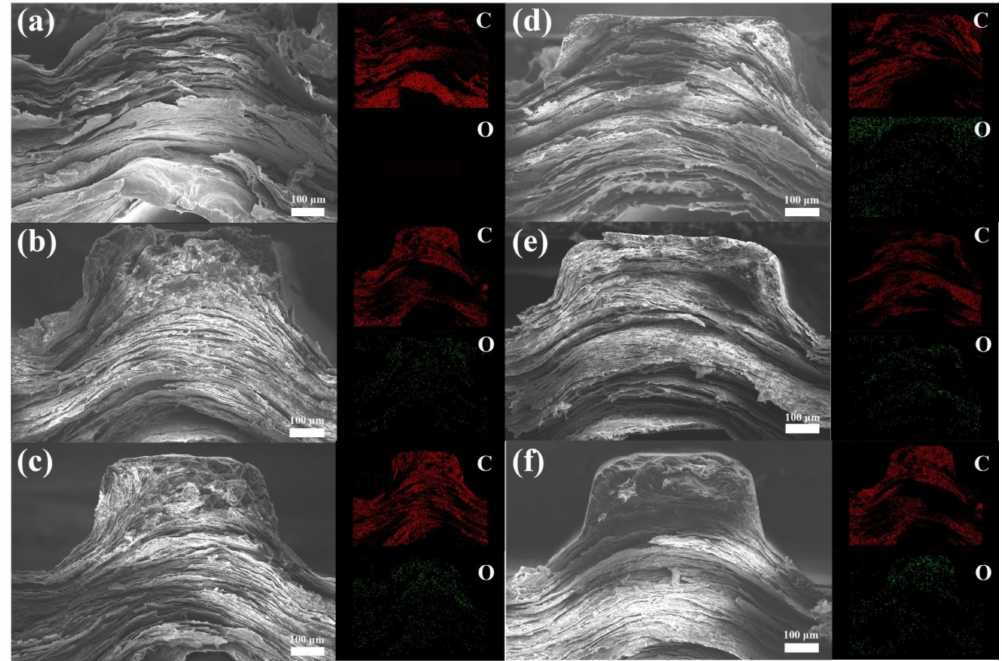
Figure 2. SEM morphology and corresponding EDS map of graphite-resin composite bipolar plates (BPs). ( a ) HU-BP, ( b ) HL-BP, ( c ) HM-BP, ( d ) HH-BP, ( e ) MH-BP, and ( f )